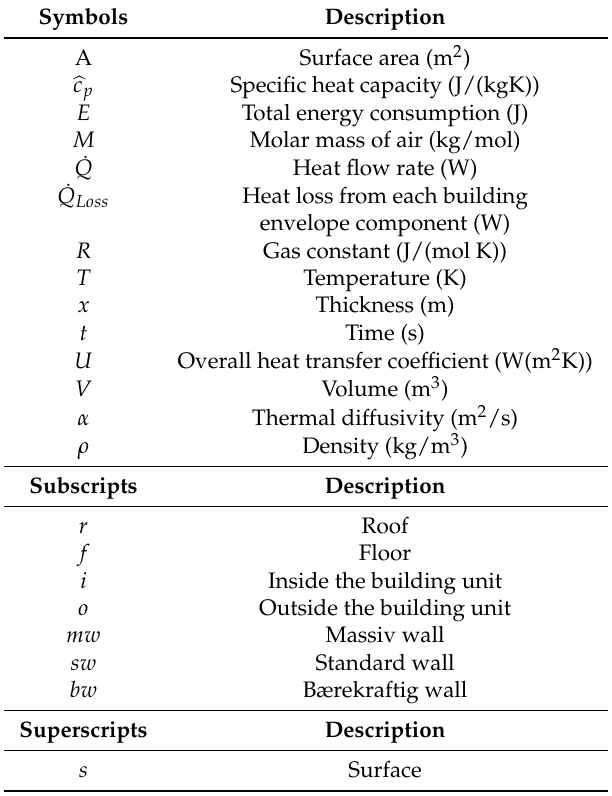
Table 1. Description of the variables and